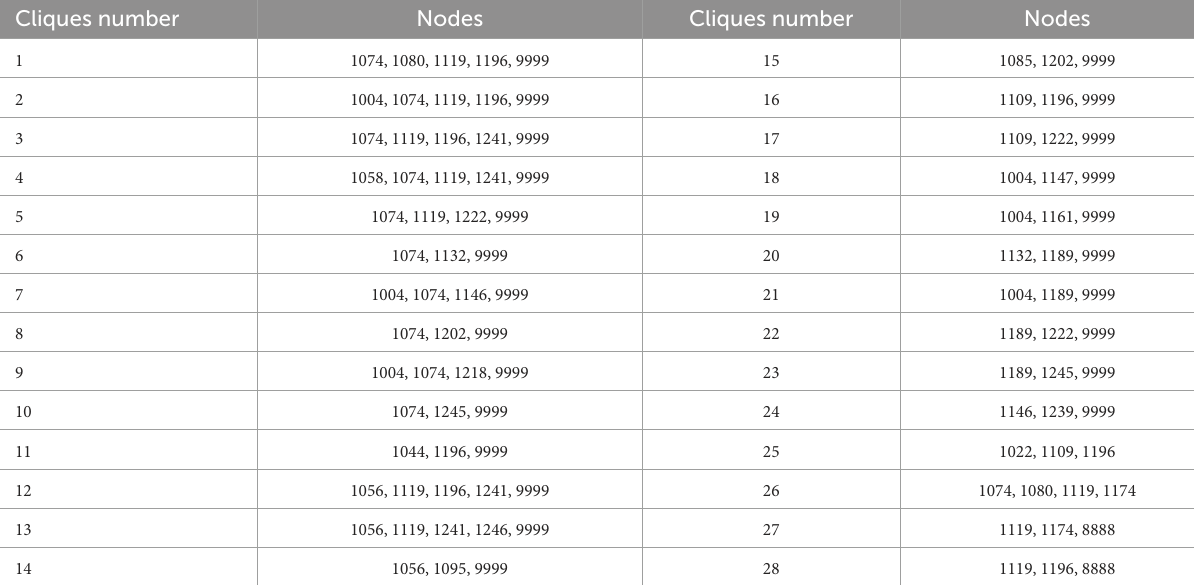
TABLE 4 The cliques of intervention